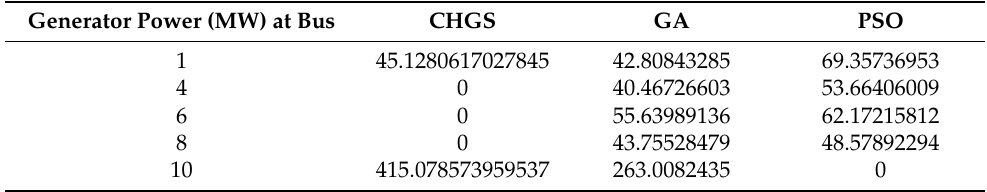
Table 3. Optimal cost and design variables for the 118-bus